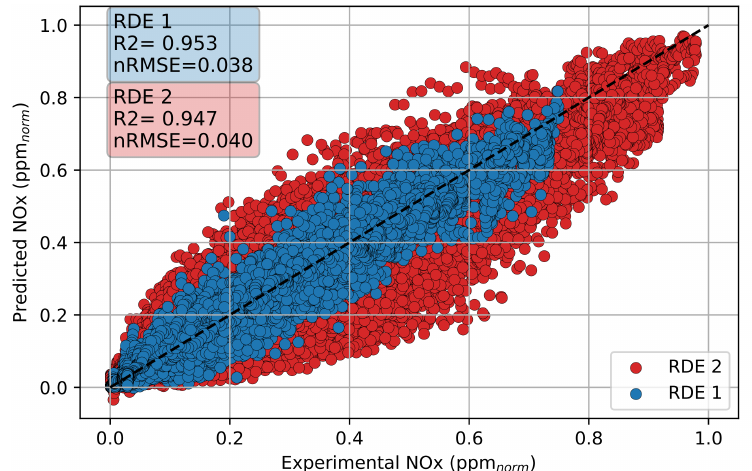
Figure 20. Sample-by-sample correlation scatter. In blue, the result of RDE 1, in red the results of RDE